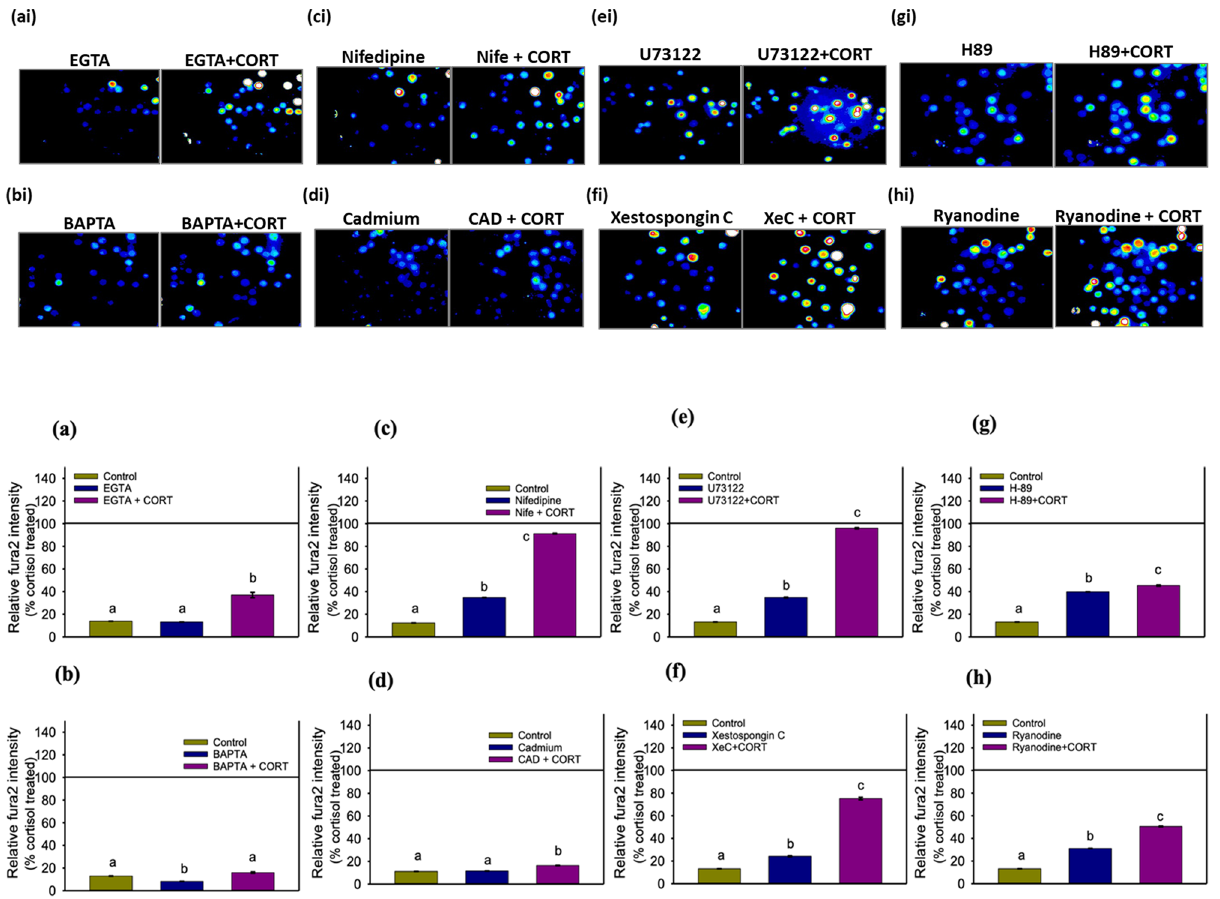
Figure 2. Pharmacological characterization of the source of calcium. Hepatocytes were treated with different blocking agents and chelators 30 min prior to cortisol addition. All results are shown as % of cortisol (100 ng/ ml)-treated fura2 intensity, which is represented by the horizontal line at 100%. Representative fluorescence images taken at 1 min either with or without the addition of cortisol are shown above (ai–hi), while the corresponding quantification is shown below as a bar graph ( a – h ). Bar graph showing fura2 intensity ([Ca 2+ ] i) changes at 60 s relative to cortisol treatment with ( a ) either control, EGTA or EGTA + Cortisol, ( b ) either control, BAPTA or BAPTA + Cortisol, ( c ) either control, Nifedipine (Nife) or Nife + Cortisol, ( d ) either control, cadmium (CAD) or CAD + Cortisol, ( e ) either control, U73122 or U73122 + Cortisol, ( f ) either control, xestospongin C (XeC) or XeC + Cortisol, ( g ) either control, H-89 or H-89 + Cortisol, ( h ) either control, ryanodine or ryanodine + Cortisol. All bars represent mean ± SEM (n = 5–6 independent fish; ~ 100 cells from each fish); bars with different letters are significantly different (one-way ANOVA; p <